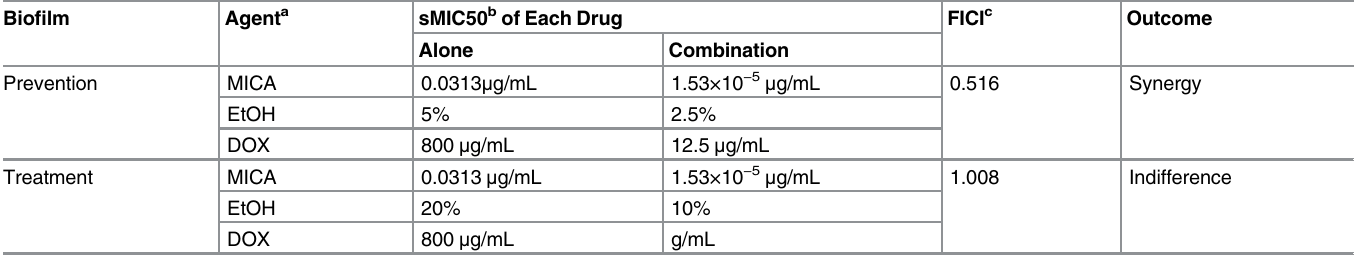
Table 3. Antifungal activity of three-drug combinations against forming and mature C . albicans biofilms, sMIC50. Bio fi lm